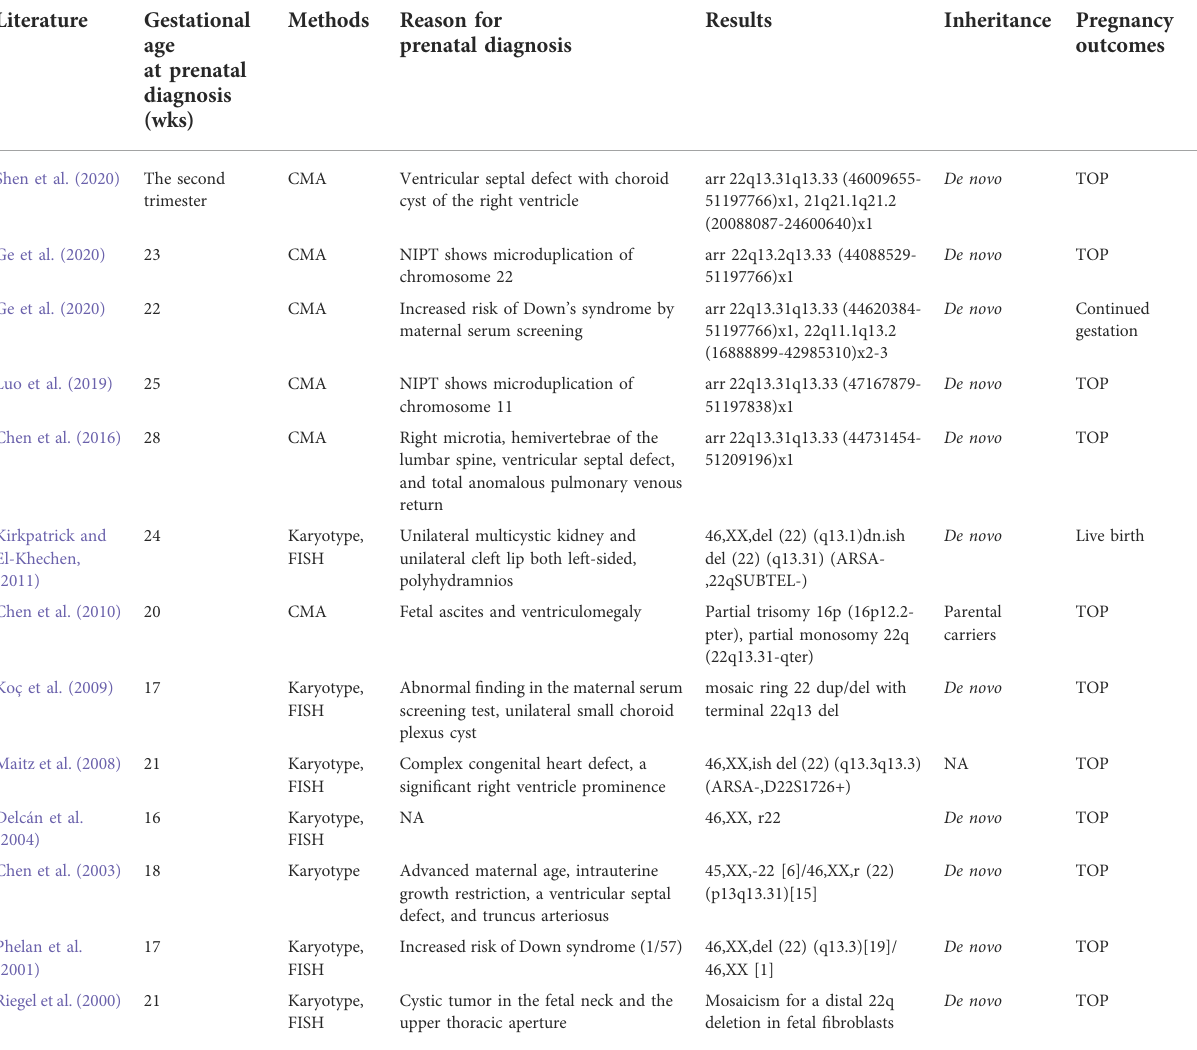
TABLE 3 Clinical features in pregnancies of PMS